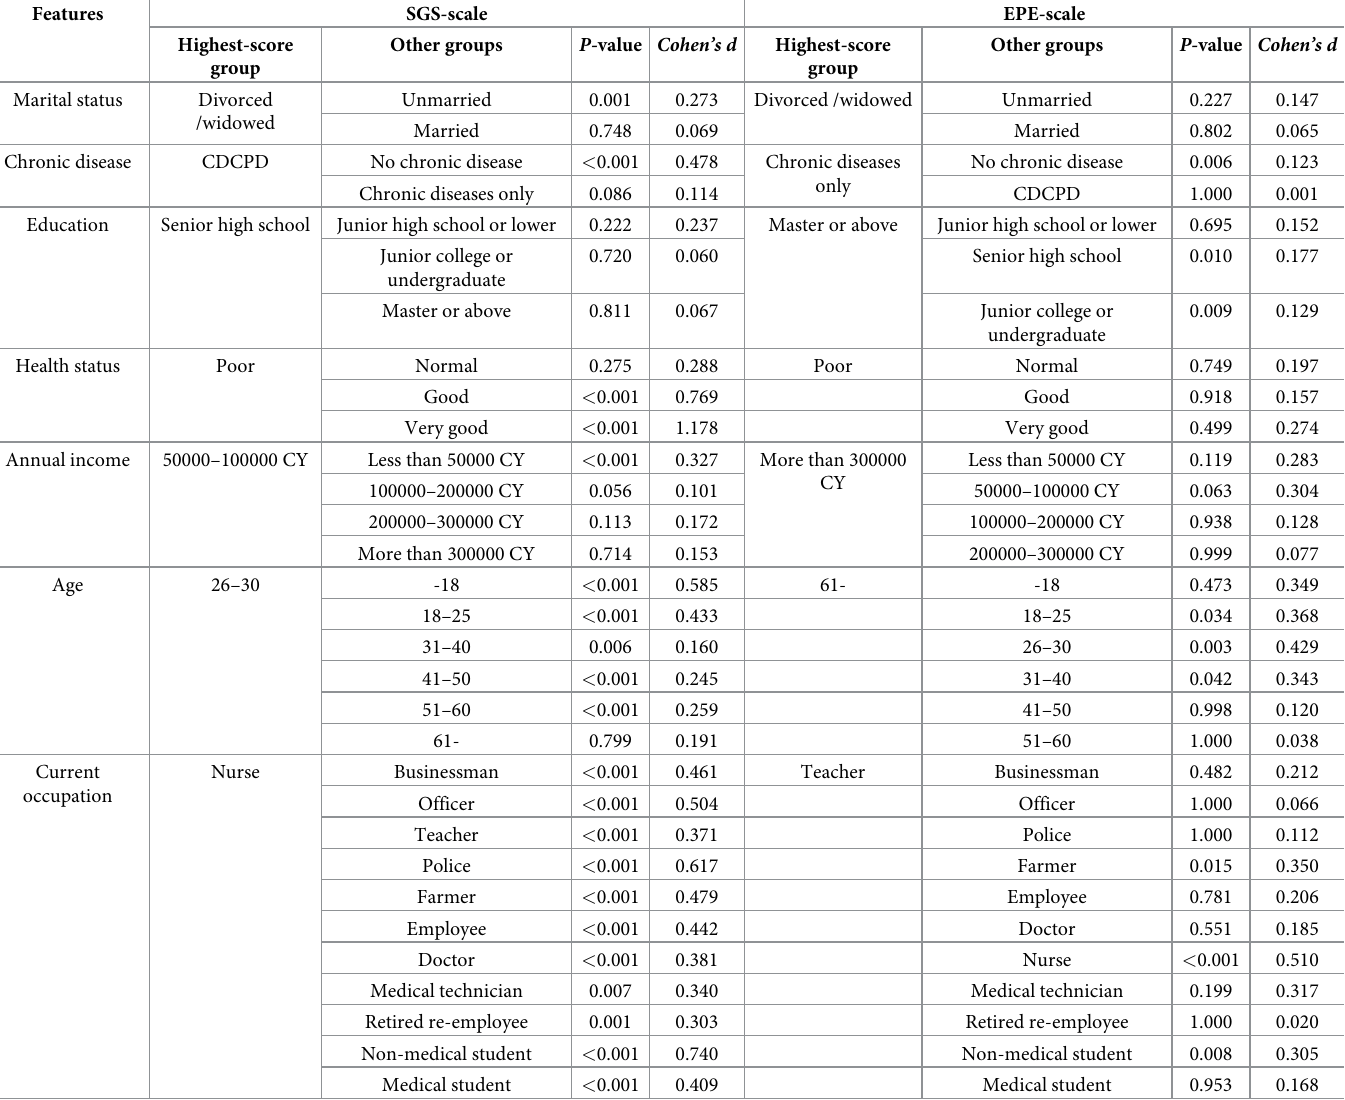
Table 3. Comparison of SGS-scale and EPE-scale scores between the group with the highest score and each of the other groups in terms of sociodemographic